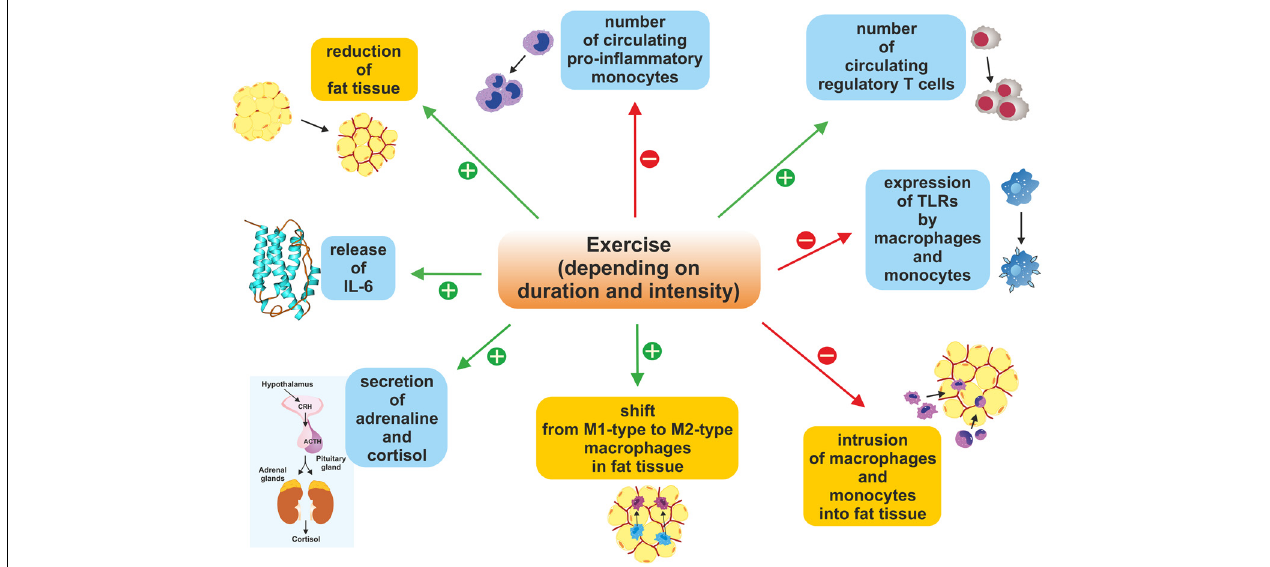
FIGURE 2 | Duration- and intensity-dependent immunomodulatory changes triggered by exercise and sporting activity. Exercise increases the number of circulating Tregs, stimulates the secretion of adrenaline and cortisol as well as the release of IL-6, leads to a reduction in fat tissue mass, and impacts the ratio of M1-type to M2-type macrophages in fat tissue. Conversely, sporting activity reduces expression of TLRs, the intrusion of macrophages and monocytes into fat tissue, and also the number of circulating pro-inflammatory monocytes. Altogether, these effects inhibit inflammatory reactions within the